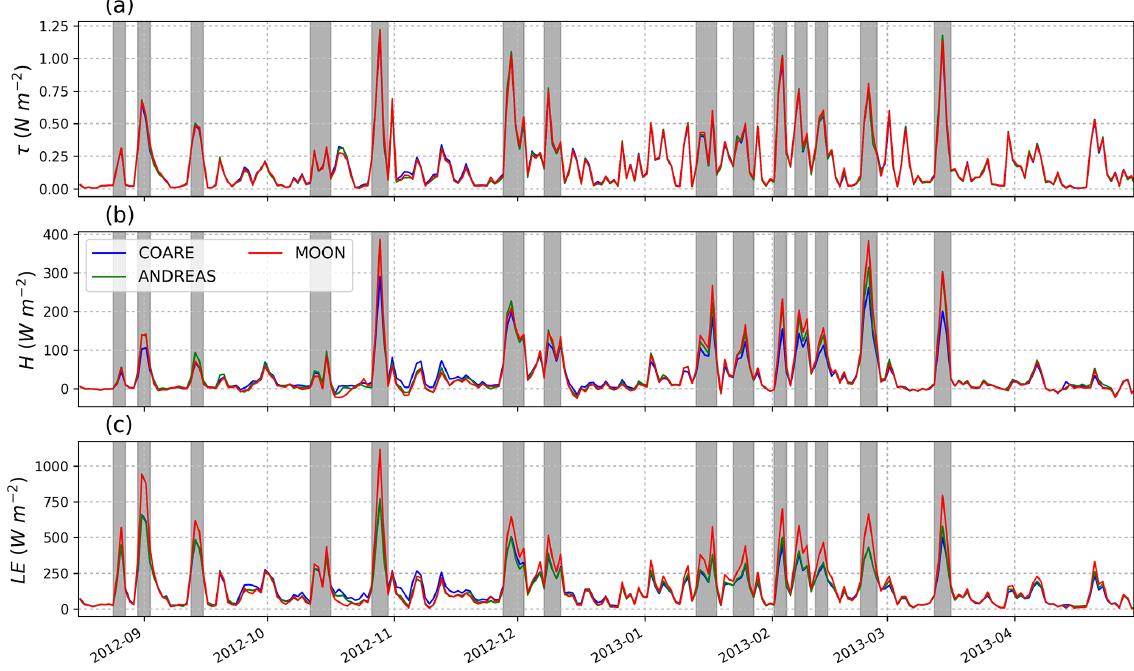
Figure 6. Time series of computed (a) wind stress, (b) sensible heat flux and (c) latent heat flux at the location of the Lion buoy for each simulation (COARE in blue, ANDREAS in green and MOON in red). The grey bars correspond to the strong wind periods (hourly wind speed > 15ms − 1 ).